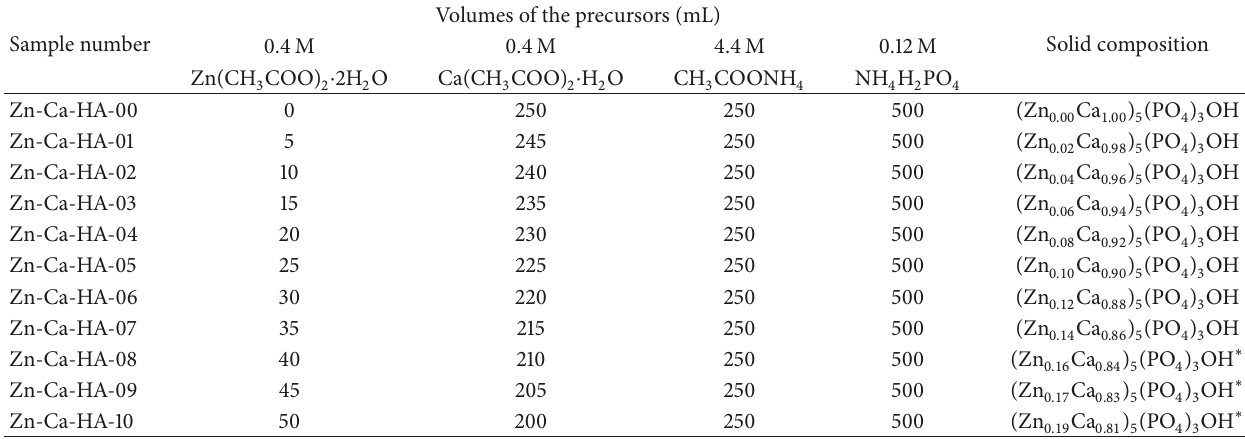
Table 1: Summary of synthesis and composition of the Zn-substituted